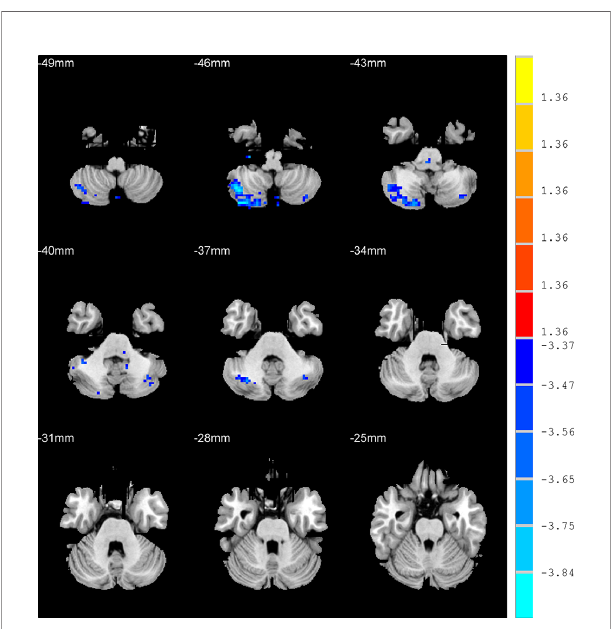
FIGURE 3 | Brain regions show the differences in the amplitudes of low- frequency fl uctuations between anxious depression group and healthy control group. The color bar signi fi es the t-value of the independent t -tests between the two groups with p < 0.001 and corrected for multiple comparisons using AlphaSim.